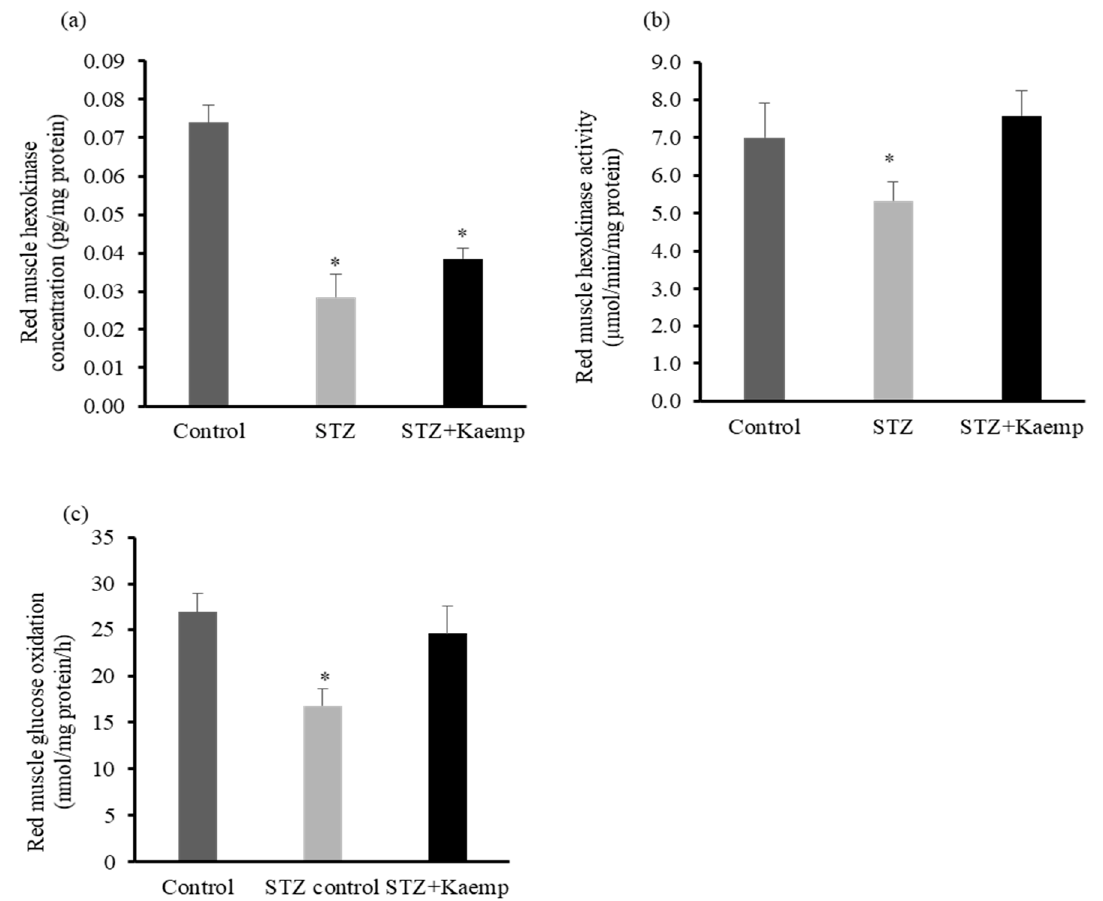
Figure 7. Kaempferol increased hexokinase activity and glucose oxidation in red skeletal muscle of STZ-induced diabetic mice. Following 12 weeks of treatment with kaempferol, ( a ) mouse liver hexokinase concentration and ( b ) activity were measured and normalized to total protein contents in the cell lysates. ( c ) Glucose oxidation in fresh mouse muscle homogenates was assayed using 14C-labeled glucose as described in the Method section. Data are shown as Mean ± SEM ( n = 8–9). * p < 0.05 vs. Control nondiabetic mice. Control: nondiabetic mice; STZ: STZ-induced diabetic mice; STZ + Kaemp: STZ-induced diabetic mice treated with kaempferol (50 mg/kg